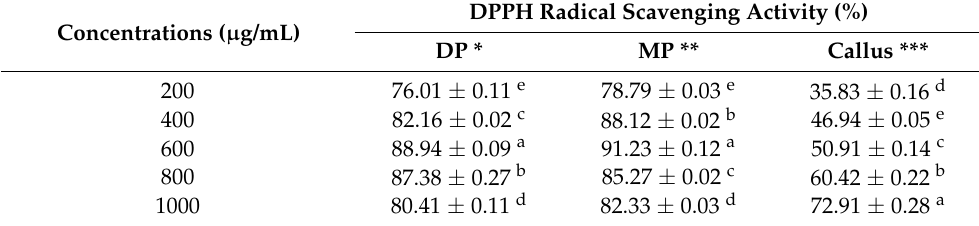
Table 5. Radical scavenging activity (%) of R. chalepensis donor plant growing in soil in the botanical garden, ex-vitro-established micropropagated plants, and callus obtained from MS + 2,4-D (10 µ M) + BA (1.0 µ